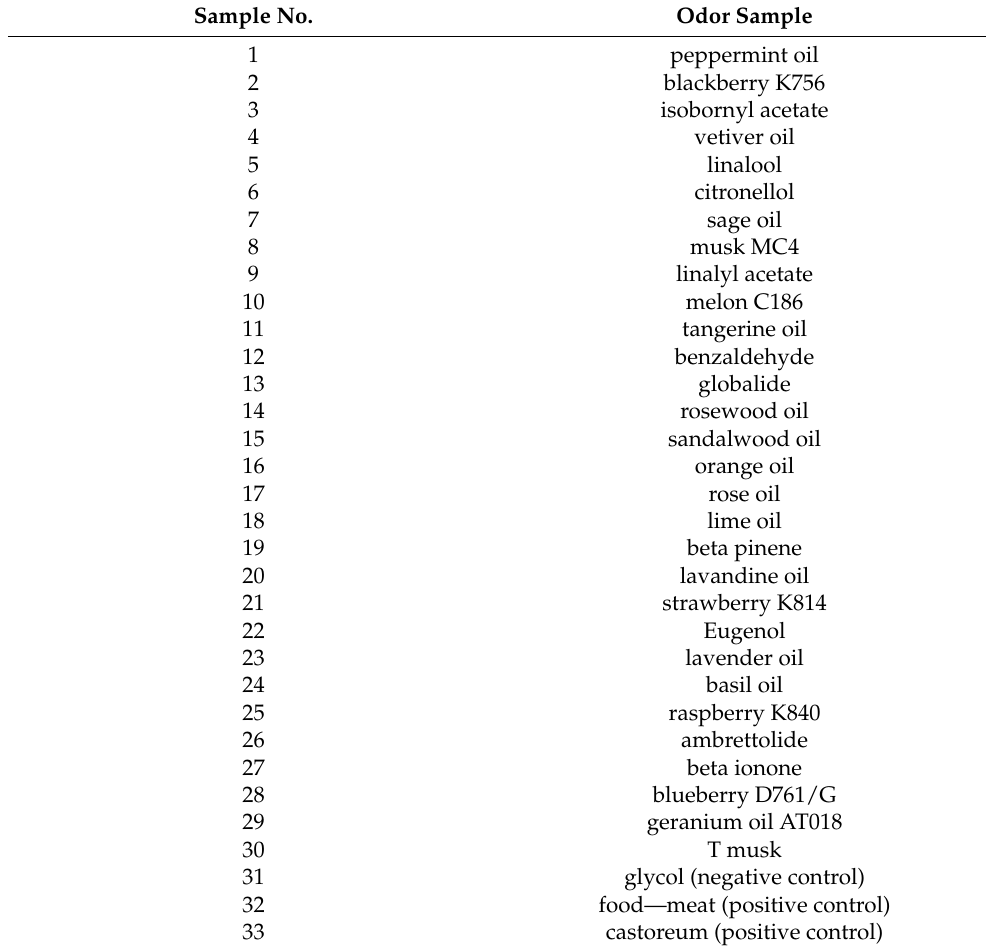
Table 2. Odor samples used in the